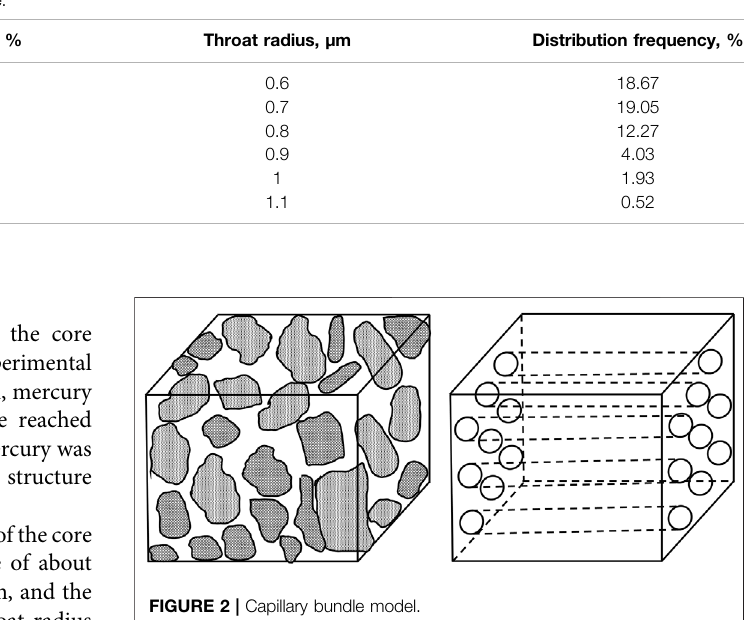
TABLE 2 | Frequency distribution of throat radius of the core sample.